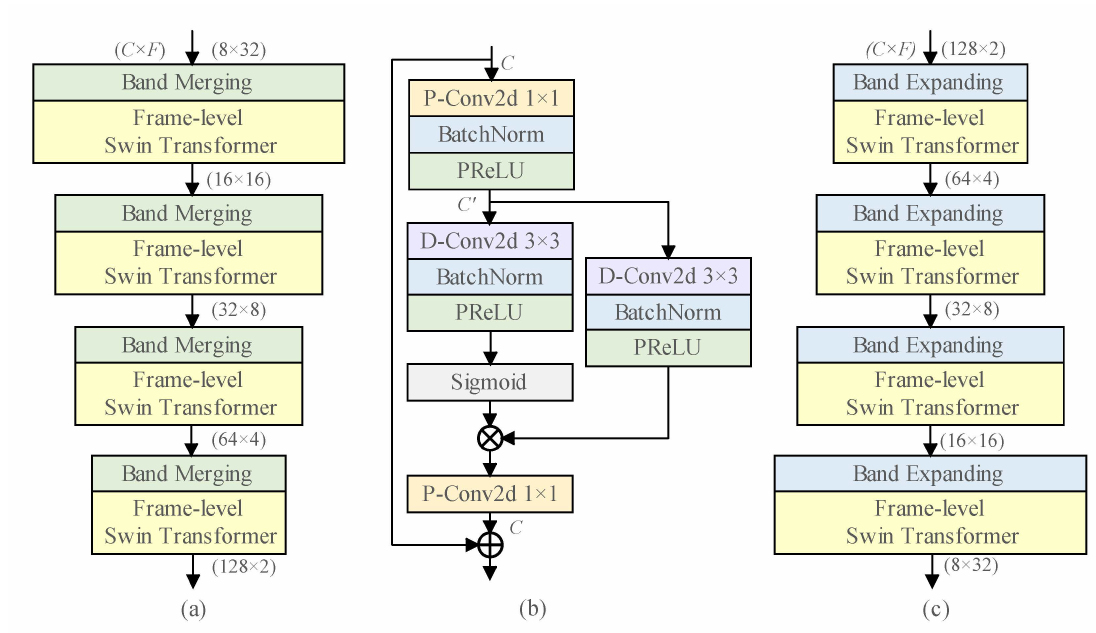
Figure 2. ( a ) The detail of encoder. ( b ) The proposed lightweight TFCM. ( c ) The detail of